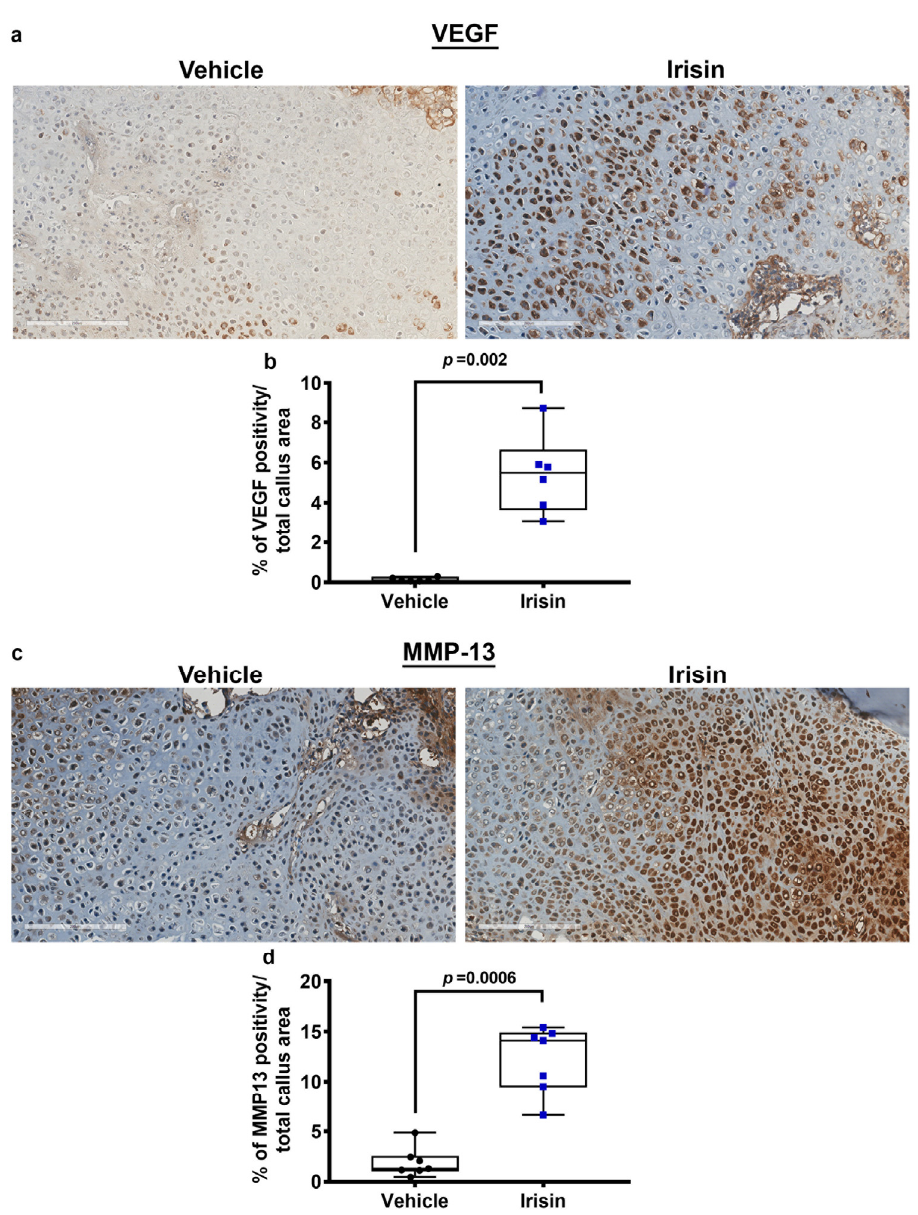
Figure 3. Representative images of ( a ) VEGF and ( c ) MMP-13 immunostaining on callus section from vehicle-treated mice ( n = 6) and irisin-treated mice ( n = 6) 10 days after fracture (scale bars 200 µ m). Quantification of ( b ) VEGF and ( d ) MMP-13 expression are shown as dot plots. Data are presented as dot plots with median, from max to min, and all data points are shown. Mann–Whitney test was used to compare groups.